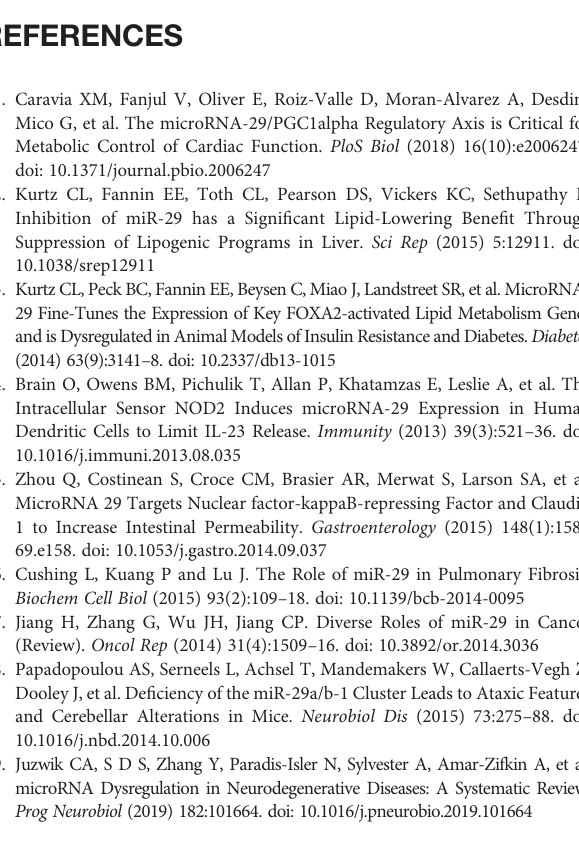
quantitative RT-PCR in different tissues. Pre-miR-29a or pre-miR-29b 1 levels were decreased in miR-29a/b 1 +/- mice (n=10) and hardly detected in miR-29a/b 1-/- mice (n=10) compared to wild-type littermates (n=8). Supplementary Figure 2 | Representative cell morphological changes in vaginal smears and estrous cycle pattern of four female mice in each wild-type and miR- 29a/b 1 KO groups are shown. Supplementary Figure 3 | miR-29a expression patterns. (A) miR-29a expression patterns in wild-type mice during the estrous cycle in pituitary and ovary tissues (n=10). 1, proestrus; 2, estrus; 3, metestrus; 4, diestrus. (B) Relative expression levels of miR-29a , miR-29b and miR-29c in hypothalamus, pituitary and gonad (HPG axis) of wild-type and miR-29a/b 1 KO mice ( ♀ miR-29c: hypothalamus: p=0.6648 , pituitary: p=0.4896 , ovary: p=0.8028 , ♂ miR-29c: hypothalamus: p=0.0727 , pituitary: p=0.1225 , testis: p=0.5042 , n=5). Supplementary Figure 4 | Wet testis and seminal vesicle (SV) weight in males, normalized to body weight in the same animals (testis: wild-type: 0.7234 ± 0.02481, n=8, miR-29a/b 1 KO: 0.9563 ± 0.03834, n=9, p=0.2107 ; seminal: wild-type: 0.6085 ± 0.07193, n=8, miR-29a/b 1 KO: 0.5191 ± 0.03874, n=9, p=0.2764 ). Supplementary Figure 5 | Levels of selected hormones in females. (A – C) Serum FSH (wild-type: 12.23 ± 1.415, n=8, miR-29a/b 1 KO: 13.62 ± 1.255, n=13, p=0.4850 ) (A) and Testosterone (wild-type: 2.774 ± 0.1147, n=10, miR-29a/b 1 KO: 2.711 ± 0.2052, n=9, p=0.7867 ). (B) and Estradiol (wild-type: 207.9 ± 13.89, n=17, miR-29a/b 1 KO: 179.3 ± 15.54, n=19, p=0.1834 ). (C) of wild-type and miR-29a/b 1 KO mice were determined. (D) Expression of hormone synthesis-related gene in the ovaries in wild-type (n=4) and miR-29a/b 1 KO (n=10) females ( cyp11a : p=0.0159 , cyp17a 1 : p=0.6094 , cyp19a 1 : p=0.9604